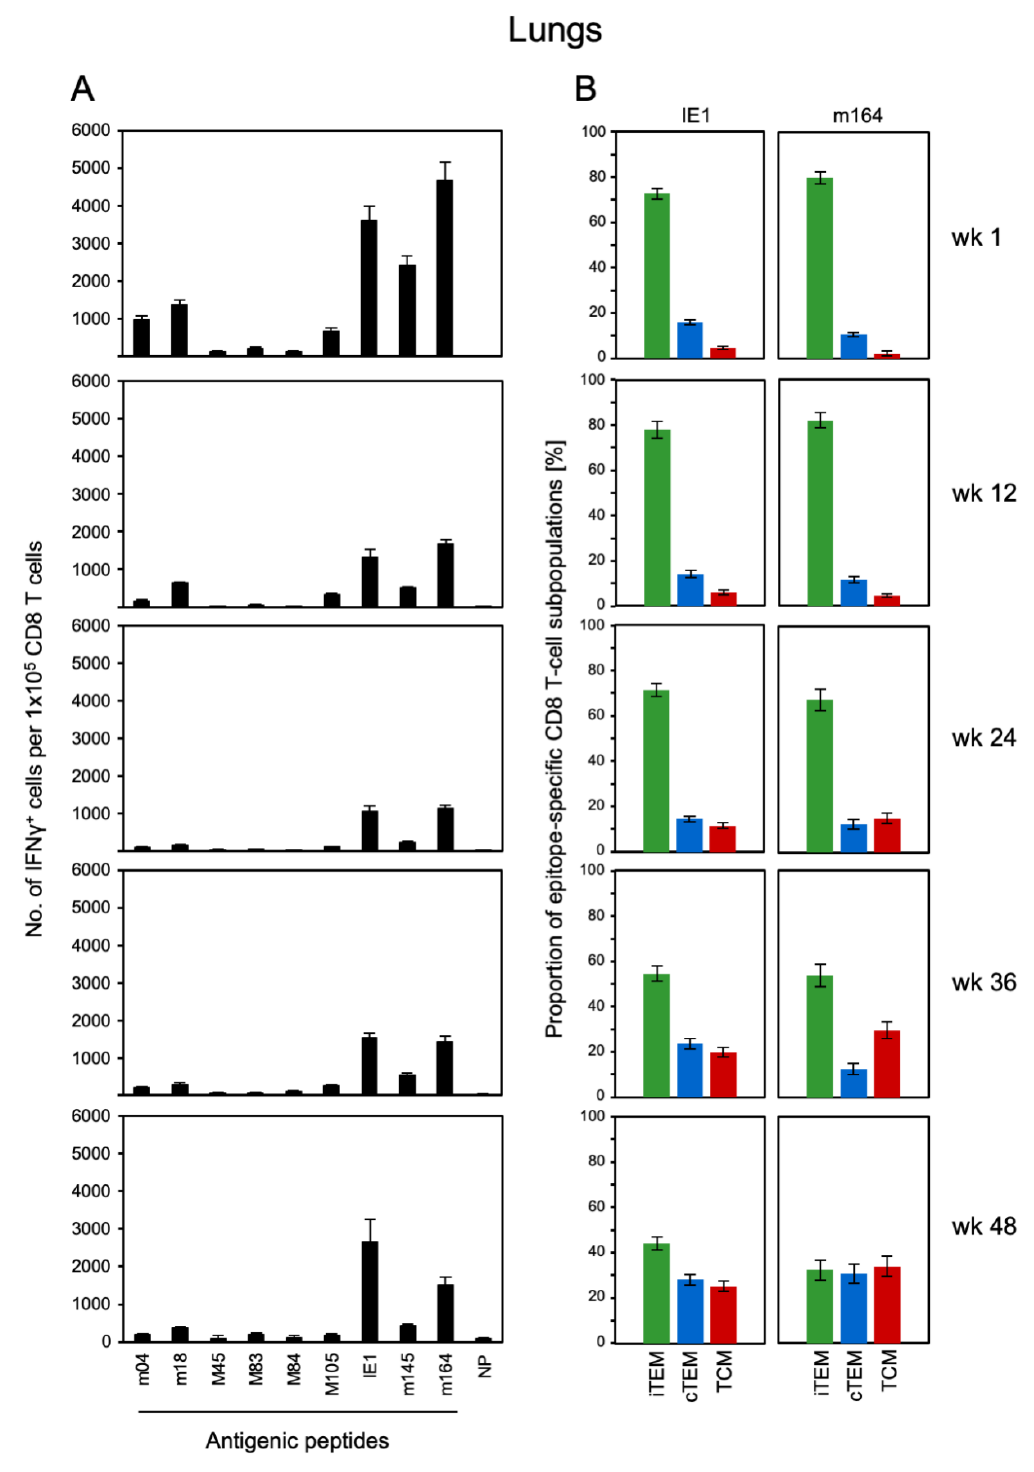
Figure 3. Kinetics of CD8 T-cell specificity repertoires and activation phenotypes in the lungs. Corresponding to the data shown in Figure 2 for the spleen, frequencies of viral epitope-specific functional CD8 T cells ( A ) and proportions of iTEM, cTEM, and TCM ( B ) were determined for pulmonary CD8 T cells from the same pools of mice. For more detail, see Figure 2.